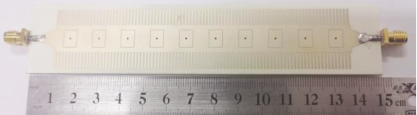
=3.17 nH, L =6.41nH, R 1 R 2